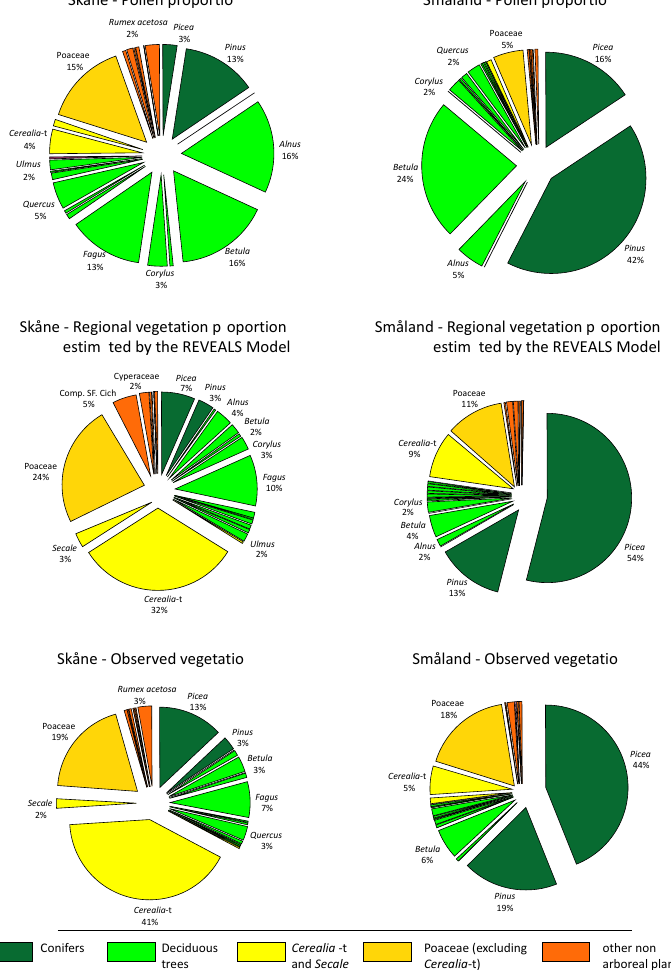
Fig. 6. Validation of the REVEALS model in southern Sweden, provinces of Sk˚ane (left) and Sm˚aland (right): comparison of pollen percentages, REVEALS estimates, and actual vegetation for 26 taxa. See Fig. 8 for the locations of Sk˚ane and Sm˚aland. Only taxa represented by ≥ 2% are named. REVEALS was run with the pollen productivity estimates from southern Sweden (Brostr¨om et al., 2004). Note the underrepresentation in pollen percentages of cereals (yellow), Poaceae (grasses; orange) and other non-arboreal taxa (herbs and shrubs; red), and the overrepresentation of deciduous trees (light green), Betula (birch) and Alnus (alder) in particular, compared to the share of these taxa in the actual vegetation and in REVEALS estimates. Pinus (pine) is dominant among conifers (dark green) in the pollen assemblage, while Picea (spruce) is dominant in the vegetation and REVEALS estimates. Other deciduous trees: Corylus (hazel), Fagus (beech), Quercus (oak), Ulmus (elm). Cereals: Cerealia-t (cereals, rye excluded), Secale (rye); other non-arboreal taxa (herbs): Compositae Sub-Family Cichorioidae (lettuce, dandelions and others), Cyperaceae (sedges), Rumex acetosa -t (sorrels, in particuler common sorrel and sheep’s sorrel). The taxa with values < 2% in pollen assemblages, actual vegetation and REVEALS estimates are: Deciduous trees – Acer (maple), Tilia (linden), Carpinus (hornbeam), Fraxinus (ash), Salix (willows); Other non arboreal taxa – Juniperus (juniper), Calluna (heather), Filipendula (meadowsweets), Potentilla (cinquefoils), Ranunculus acris type (buttercups), Rubiaceae (bedstraws), and Plantago lanceolata (ribwort). For details, see Hellman et al. (2008a,